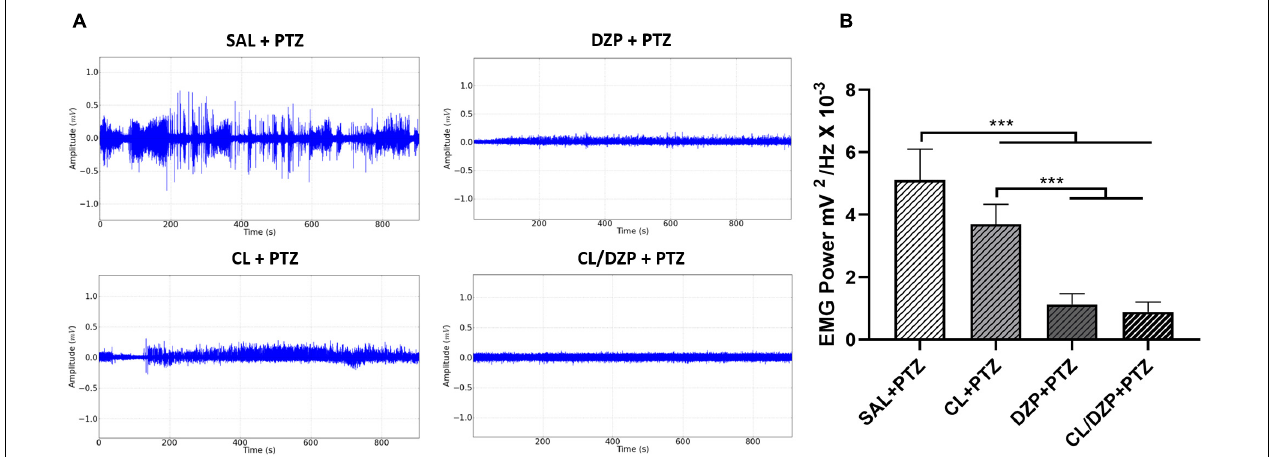
FIGURE 5 | Surface electromyographic recordings of PTZ-induced seizures pretreated with Curcuma longa and/or diazepam. (A) Electromyographic linear trace. (B) Quantitative linear distribution of the power of the muscle contraction. The data are expressed as the mean ± SD ( n = 9 per group); *** p < 0.001. SAL, saline; CL, Curcuma longa ; DZP, diazepam; PTZ, pentylenetetrazol.